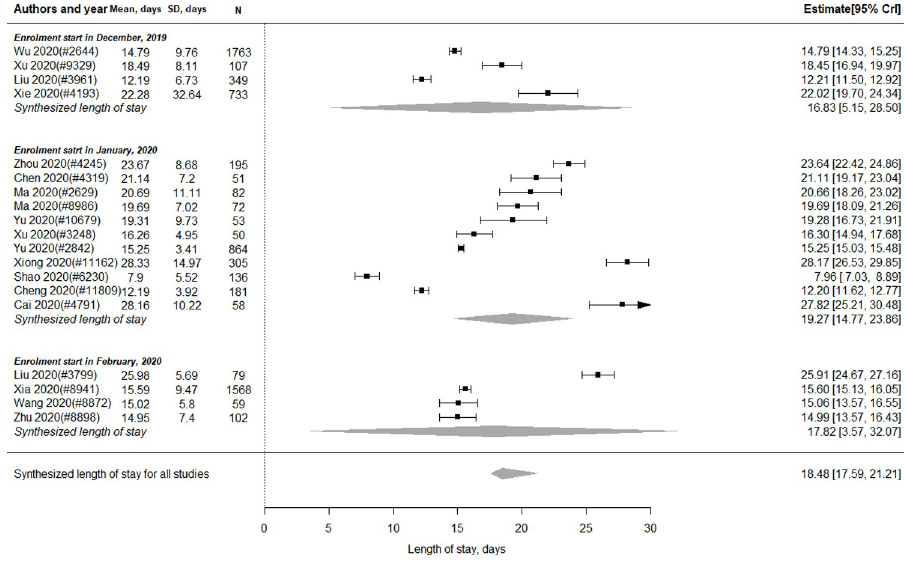
Fig 3. Length of hospital stay for severe or critical COVID-19 patients in